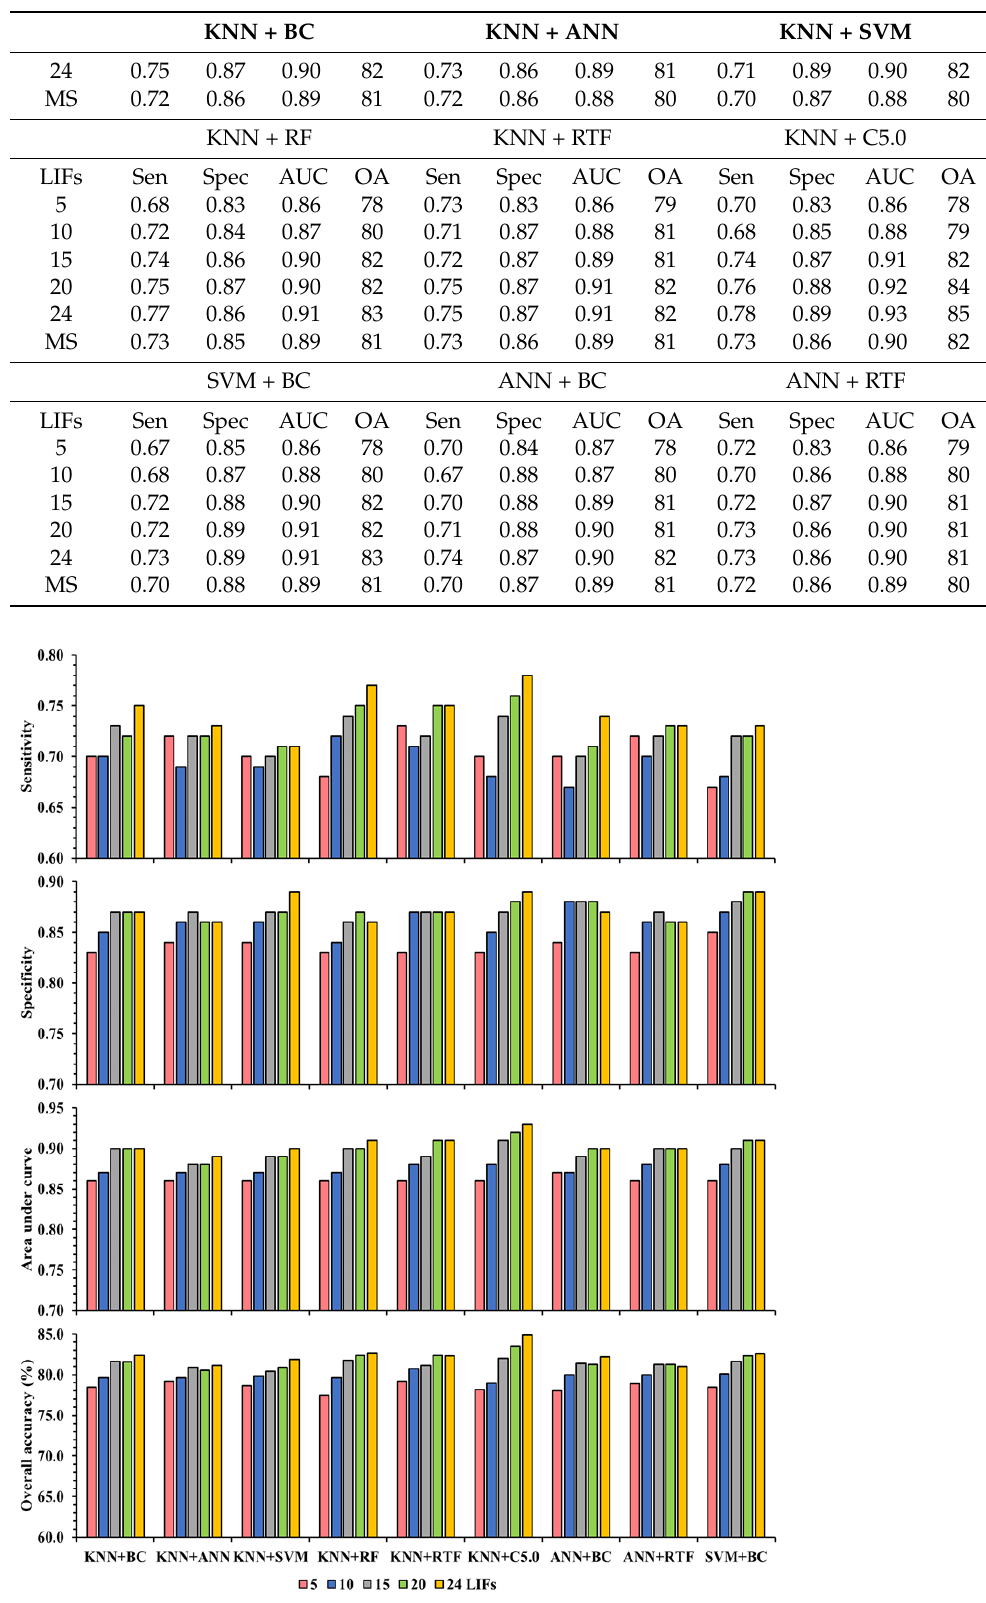
Figure 10. Accuracy statistics of ensemble ML models using different sets of LIFs.